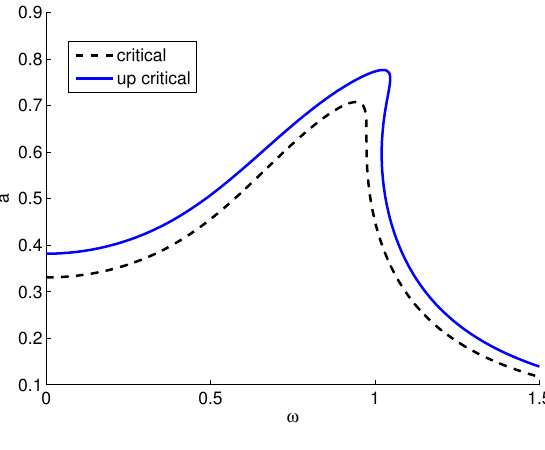
Figure 4. Frequency-response curves to show the critical forcing amplitude for the finite extensibility nonlinear oscillator as calculated using proposed method (dotted line) and a slightly larger value than this (solid line) extracted from [ 10]. Data plotted using ξ = 0 . 2 and ω NL = 0 . 75 . In this casethecriticalforcingamplitudeisnumericallycomputed (see